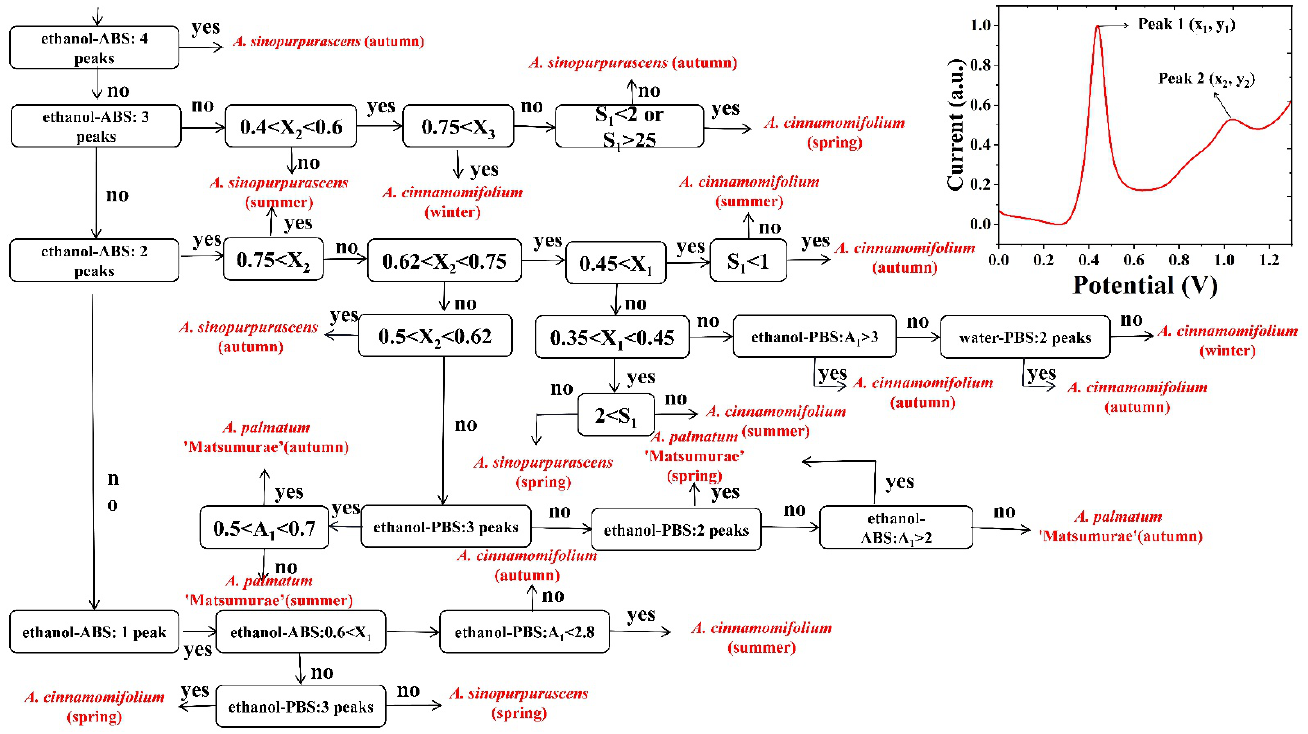
Figure 6. Flow chart of species and growing season identification of A. sinopurpurascens, A. palmatum ‘Matsumurae’ and A. cinnamomifolium .